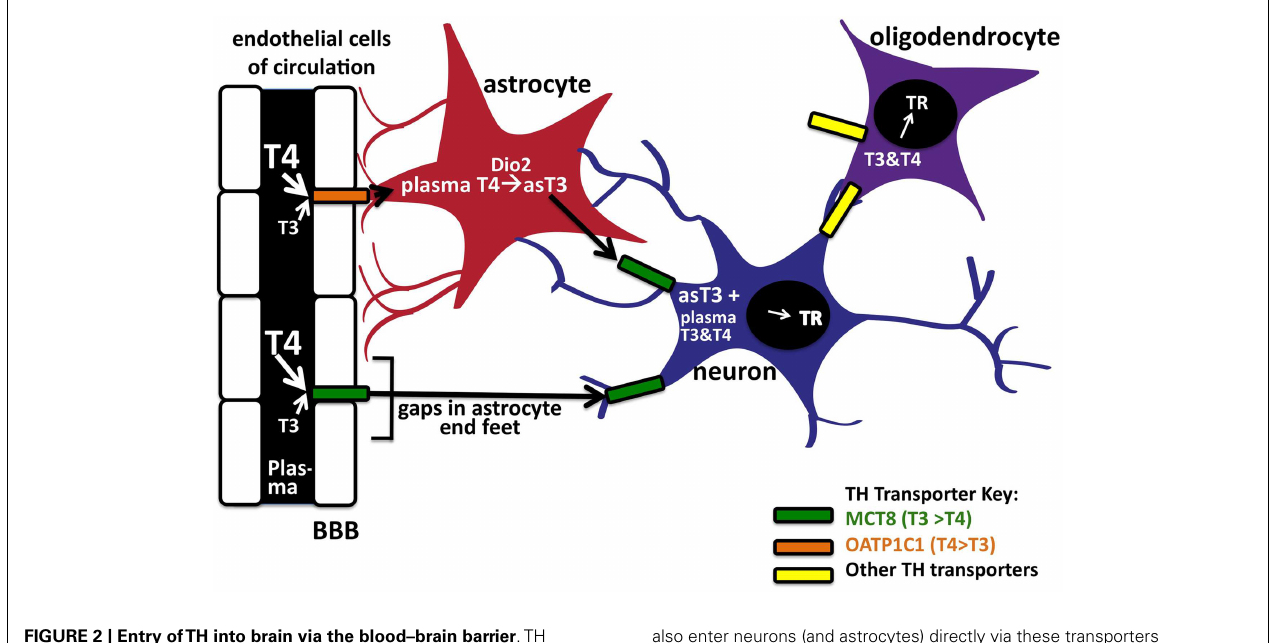
FIGURE 2 | Entry ofTH into brain via the blood–brain barrier .TH can enter neurons by two pathways.The first is by crossing the endothelial cells of the blood–brain barrier (BBB) by the OAT1P1C transporter to enter astrocyte end feet (in red). After entering astrocytes,T 4 can be converted intoT 3 via deiodinase 2, to enter the neuron (in blue) by the MCT8 transporter. CirculatingT 4 andT 3 may